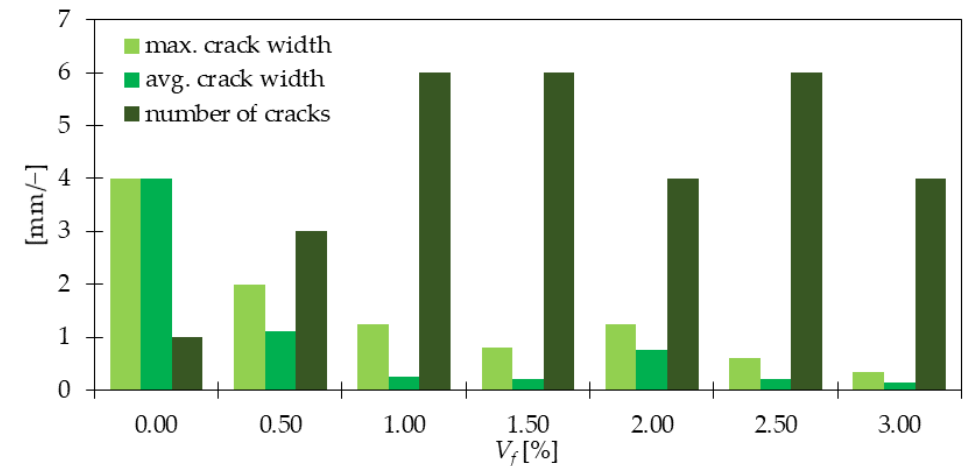
Figure 6. Influence of V f on the crack characterization of samples subjected to restrained shrinkage after 220 days of drying